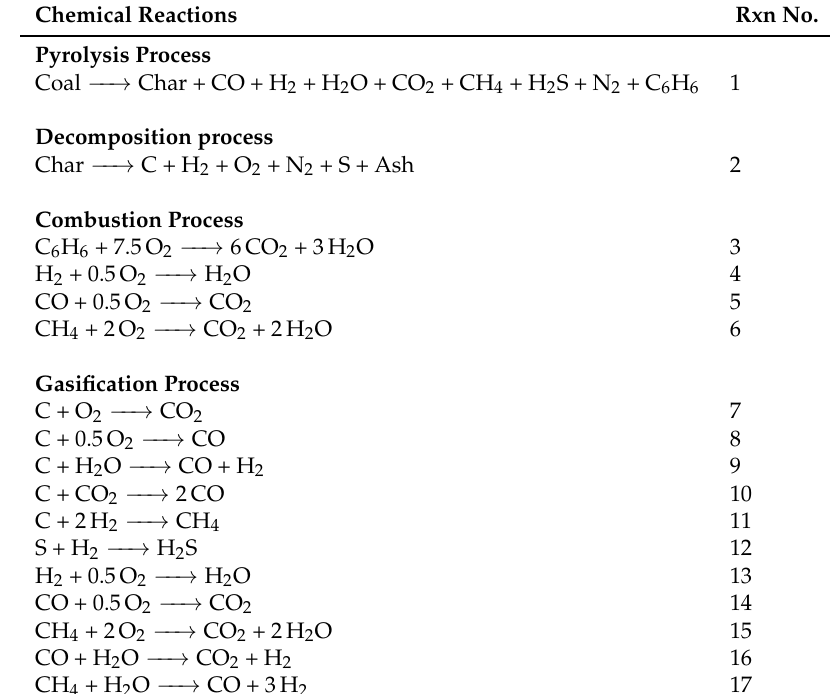
Table 2. List of reactions occuring in pyrolysis, decomposition, combustion, and gasification